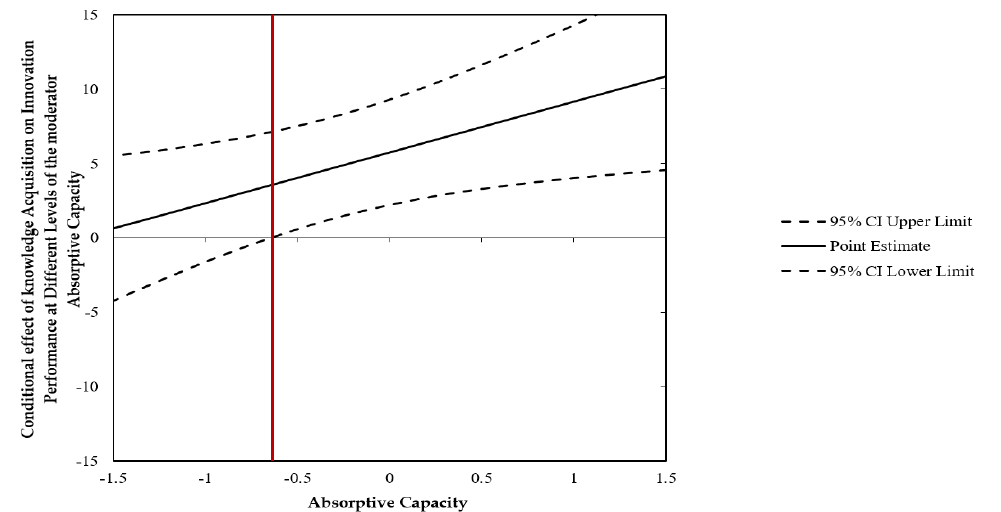
Figure 2. Conditional effect of E-E firms’ knowledge acquisition on innovation performance as a function of absorptive capacity. Table 4. Bootstrap significance test for the conditional indirect effect of knowledge acquisition on sales growth through innovation performance at different levels of absorptive capacity.